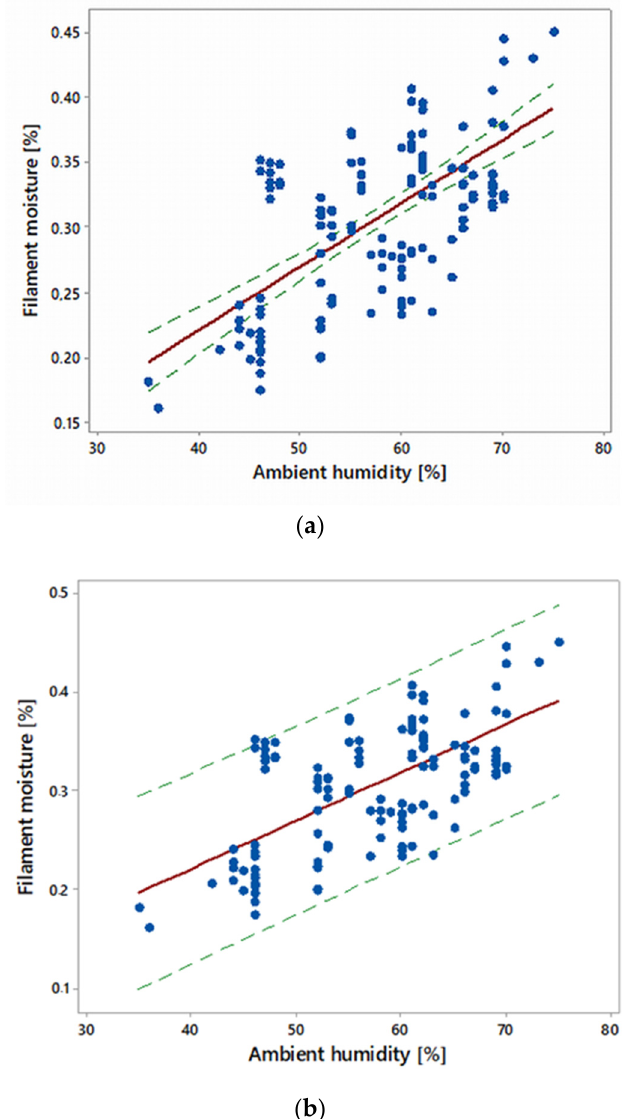
Figure 6. Regression line (red) between ambient humidity and filament moisture (sample size n = 150): ( a ) with confidence interval (green) for the mean; ( b ) with prediction interval (green) for a single observation; confidence level = 0.95.